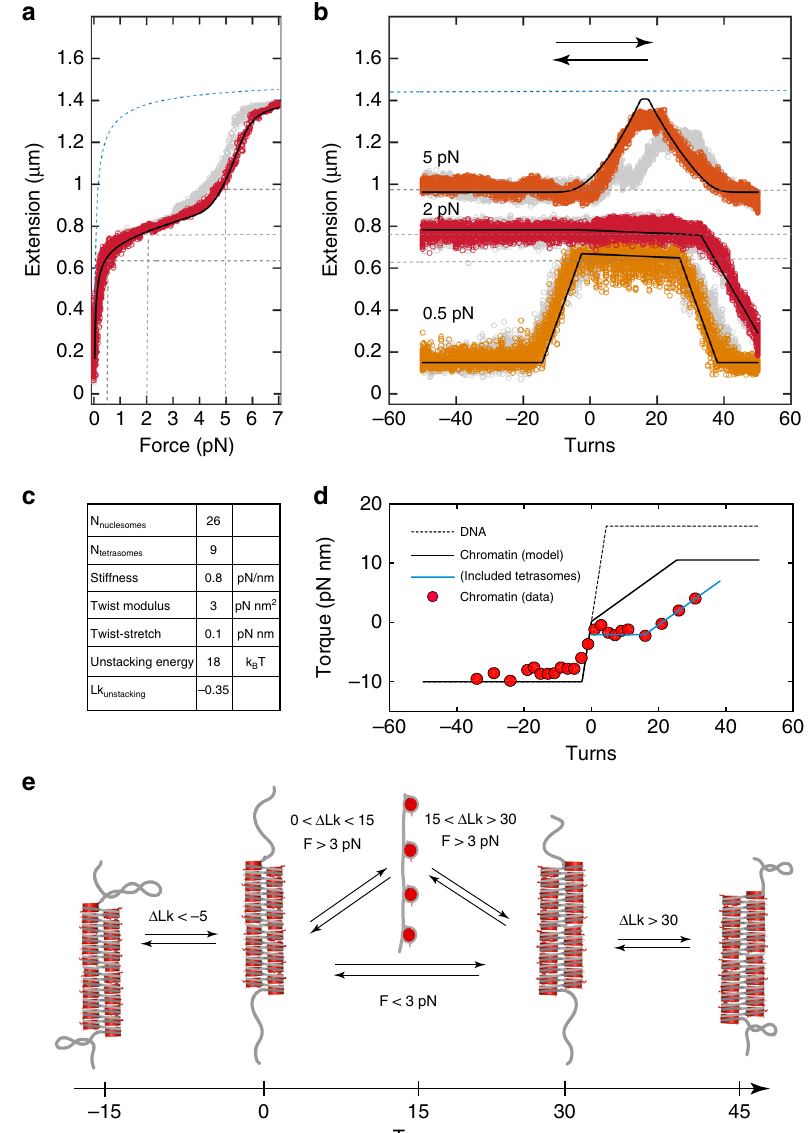
Fig. 3 167-NRL fi bers adopt a left-handed, two-start structure that refolds upon excessive positive turns. a Force-extension curve of a rotationally constrained 30 (cid:3) 167 chromatin fi ber. The initially compacted fi ber is stretched under force (red) and observed to unstack at 5.5 pN. When the force is subsequently decreased, the fi ber is observed to refold to its initial con fi guration (grey). The solid black line re fl ects the best fi t to the statistical mechanics ¼ 26 ; N ¼ 9, unstacking energy G = 18 k T and stretching stiffness per nucleosome c = 0.7 pN (cid:3) nm (cid:1) 1 , in line with the model with N s nucleosomes tetrasomes u B results shown in Fig. 2B. The dashed blue line re fl ects the extension of a DNA template with singly wrapped nucleosomes. The dashed black lines mark the forces and extensions examined during the subsequent rotation experiment. b Rotation-extension curves of the same molecule as in panel a at forces of 0.5 pN (orange), 2 pN (dark red) and 5 pN (light red). Grey curves re fl ect the measurements with a reversed direction of magnet rotation. Solid black lines re fl ect the torsional spring model using the parameters as in panel a together with a torsional stiffness c t ¼ 3 ± 1 pN (cid:3) nm 2 (mean + SD) and a twist-stretch coupling factor c ts ¼ 0.1 pN (cid:3) nm. c Table summarizing the parameters used in the quanti fi cation of curves in panels a and b . d Representative torque-twist measurement on a 167-NRL chromatin fi ber at 2 pN (red). Data was offset to equate the torque plateau at negative twist with the DNA melting torque of -10 pN (cid:3) nm. The dotted grey line represents the predicted torque build-up in the DNA handles alone. The solid black line shows the restoring torque of the chromatin tether quanti fi ed with a torsional spring model yielding a torsional stiffness c t ¼ 3 pN (cid:3) nm 2 . The solid blue line is the prognosed torque that includes a correction for twist in tetrasomes. e Schematic summarizing the structural changes in the chromatin tether under torsion. Torsionally relaxed 167-NRL fi ber (twist = 0) cannot absorb negative turns, and as such the entire linking number change is absorbed by the DNA handles. The consequences of imposed positive twist depend on the level of tension and may involve unstacking of chromatin fi ber followed by changes in its chirality. This delays the formation of DNA plectonemes compared to negative